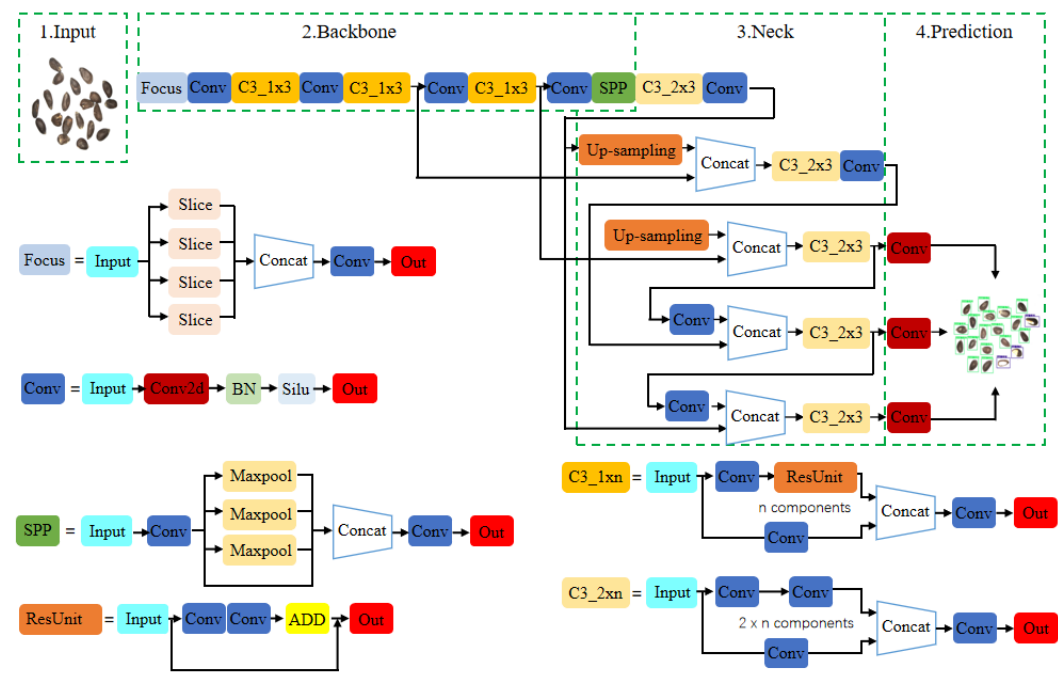
Figure 3. YOLOv5s algorithm network architecture flowchart.